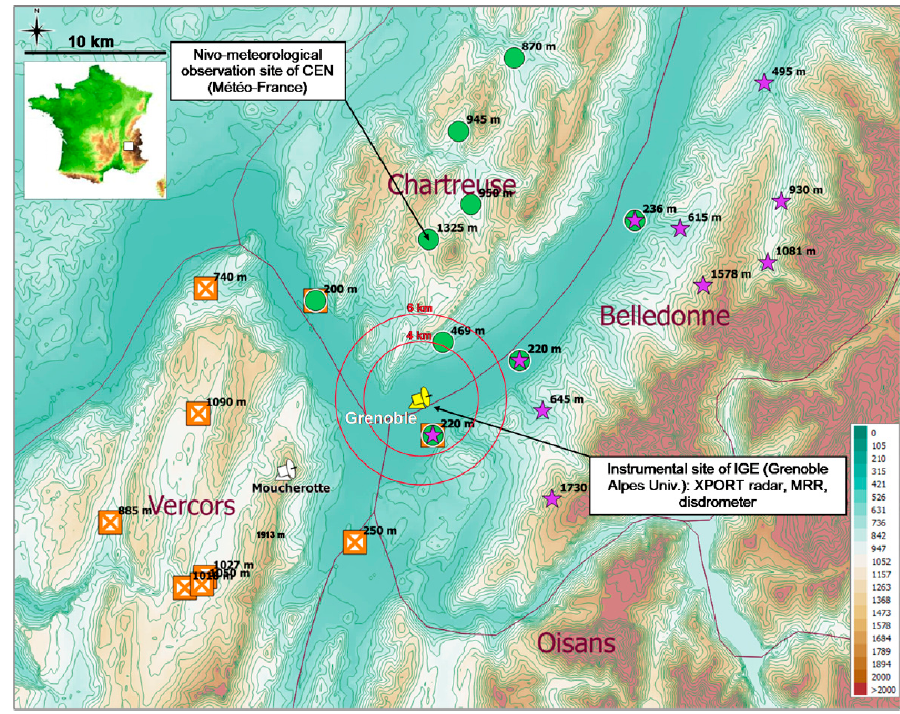
Figure 2. Relief (m) and instrumentation. Brown lines = massifs limits. Rain gauges distribution: Chartreuse (green rounds), Vercors (orange squares), and Belledonne (purple